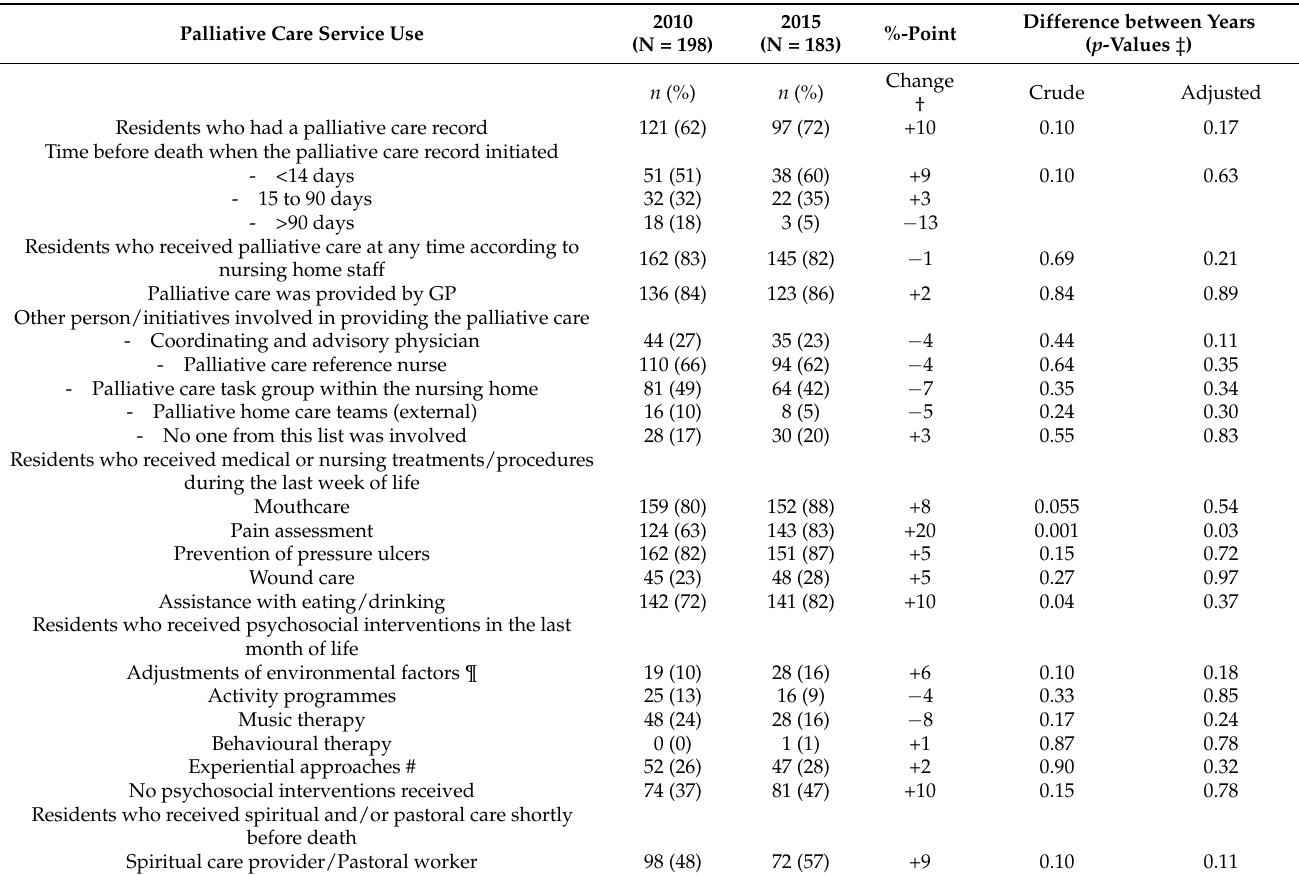
Table 2. Comparing palliative care service use between 2010 and